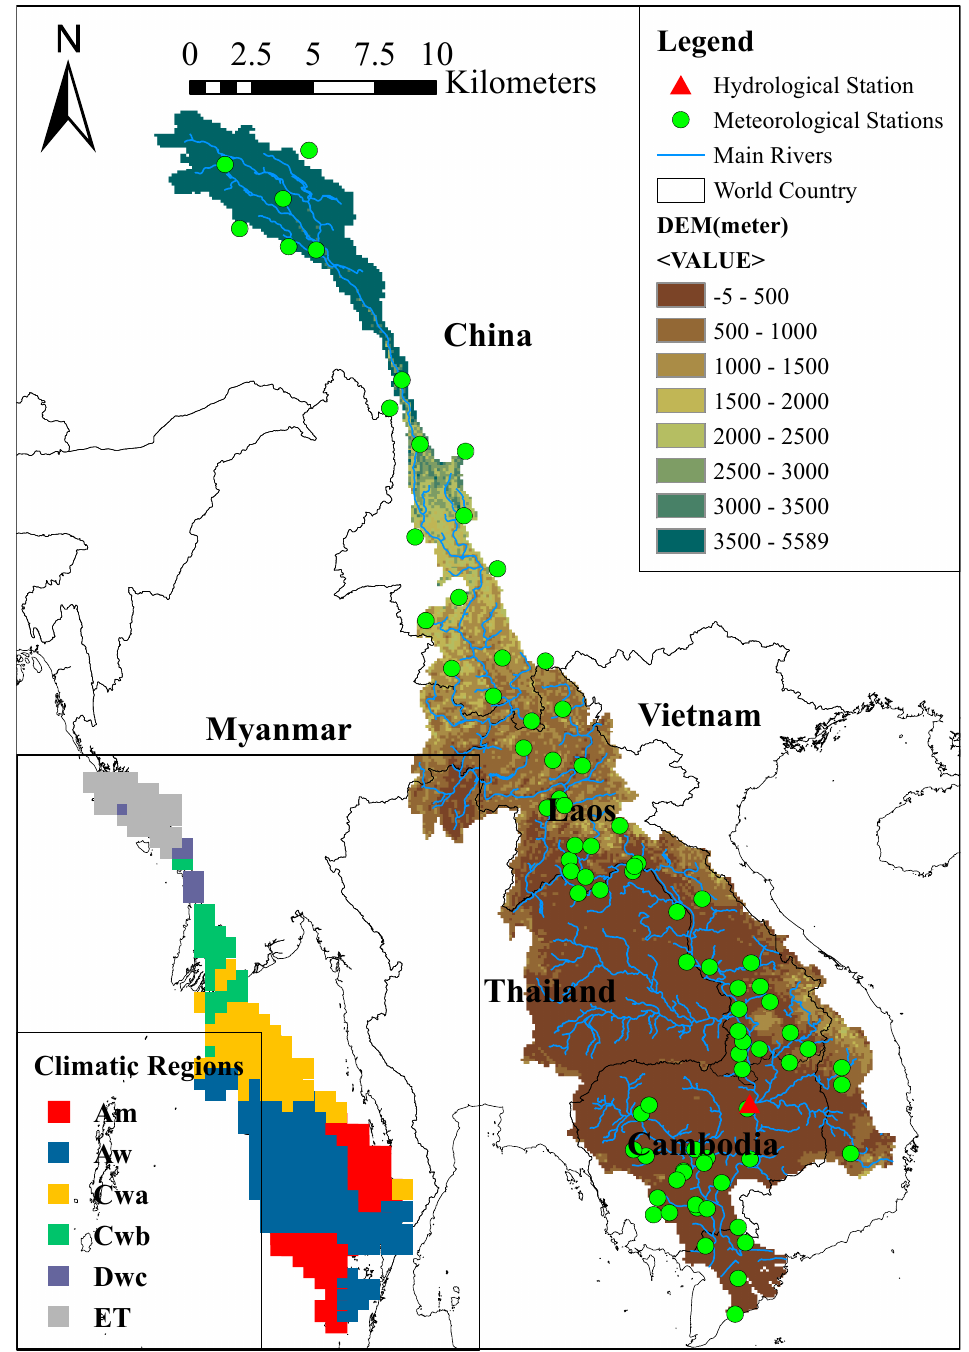
Figure 1. Locations of the Mekong River Basin (MRB) and the meteorological and hydrological stations, the sub-figure at the bottom left is the climate region classification of MRB from World Maps of Koppen-Geiger Climate Classification (Notation: A, C, D, E mean equatorial, warm temperature, snow, and polar climates, respectively; m and w mean monsoonal and desert precipitation regimes; a, b, c, and T mean hot summer, warm summer, cool summer, and polar tundra temperature features).